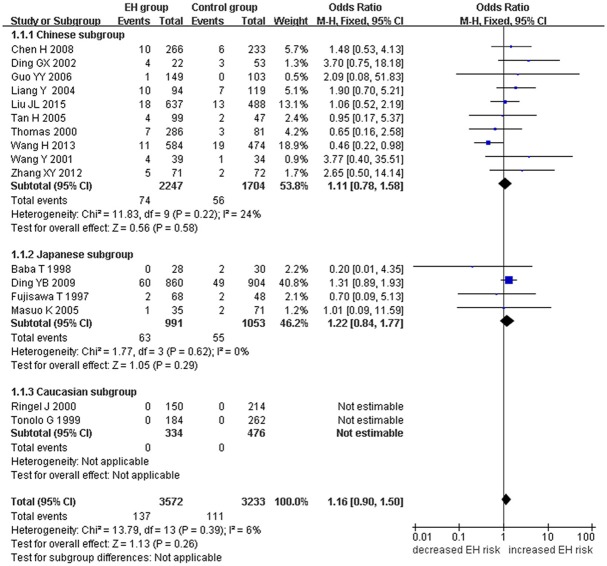
Forest plot of EH associated with ADRB3 gene Trp64Arg polymorphism under a homozygous genetic model (AA vs. TT).